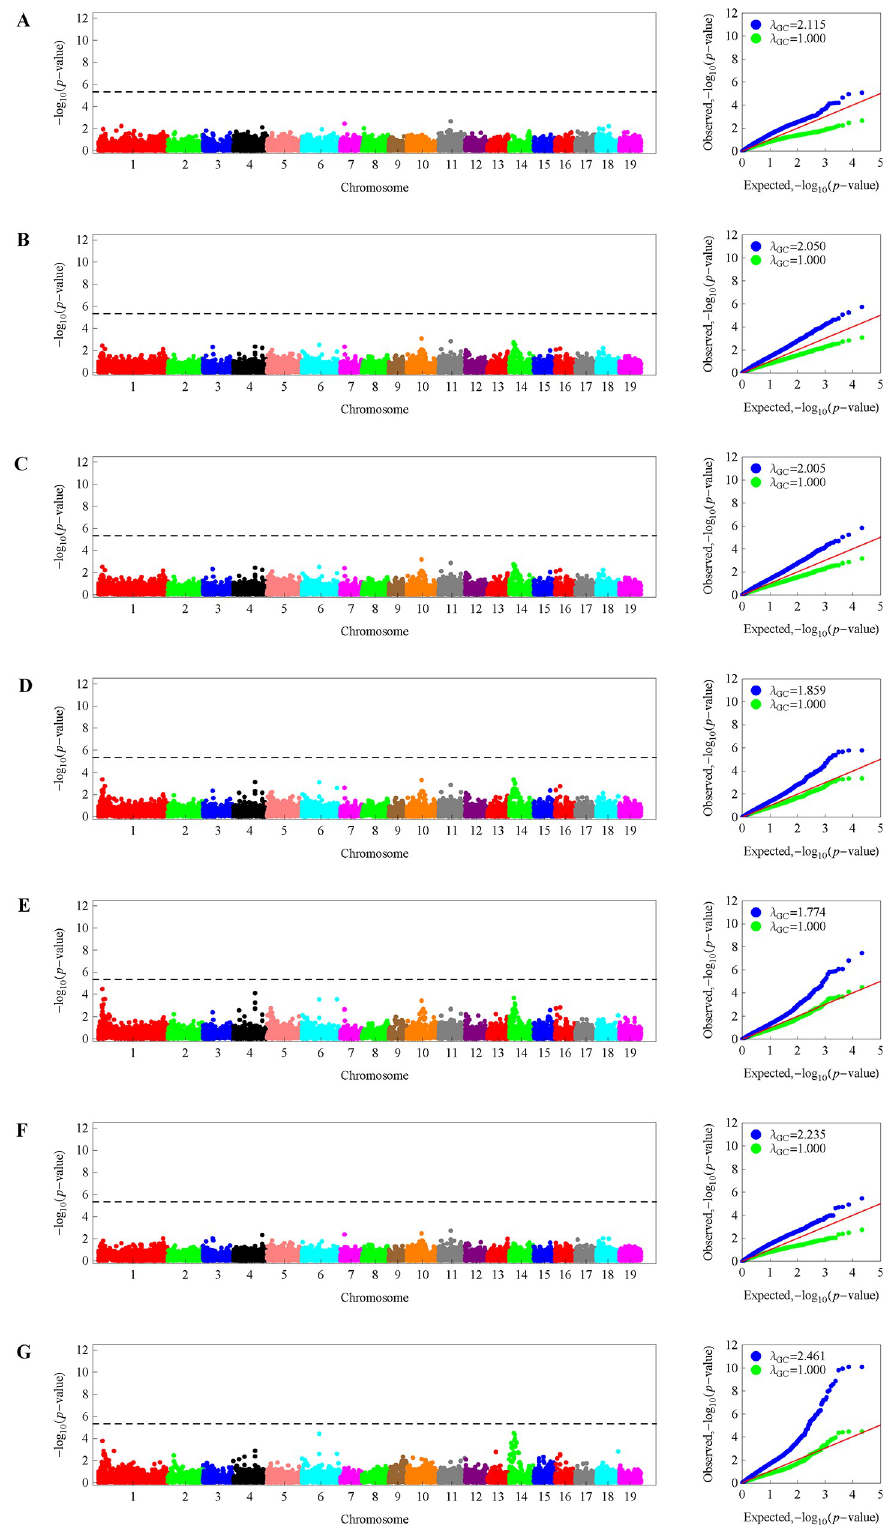
Fig 5. Manhattan and quantile-quantile (QQ) plots of the association analyses for each univariate trait, L (A), W (B), W31 (C), W21 (D), W32 (E), and A (F), and the ratio of L to W (G) across the 19 chromosomes of the